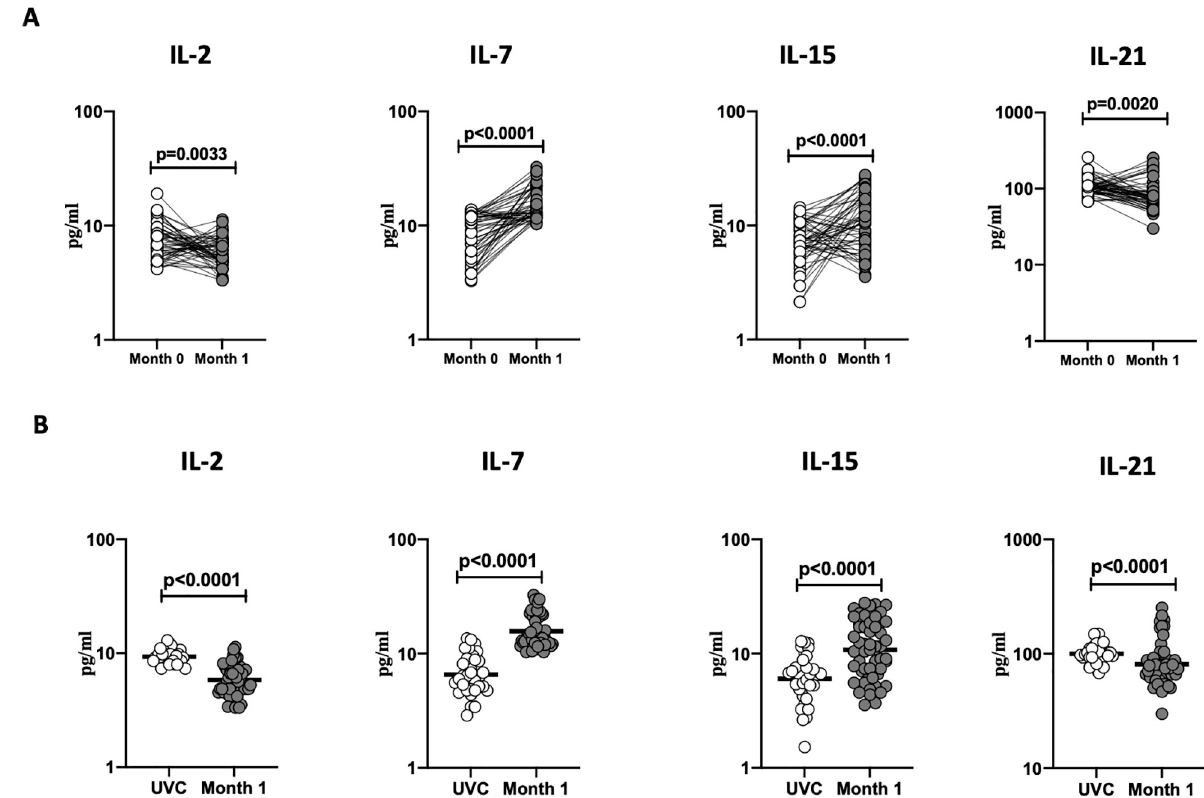
Fig 3. BCG vaccination is associated with altered circulating levels of γ c cytokines. (A) The plasma levels of common γ c cytokines IL-2, IL-7, IL-15 and IL-21were measured in BCG pre-vaccinated [M0] (n = 54) and month 1 following vaccination [M1] (n = 54). Data are shown as line diagrams with each line representing a single individual. p values were calculated using the Wilcoxon matched pair tests with Holms correction for multiple comparisons. (B) The plasma levels of common γ c cytokines IL-2, IL-7, IL-15 and IL-21in BCG unvaccinated (UVC) (n = 32) and post vaccinated [M1] (n = 54) individuals. The data are represented as scatter plots with each circle representing a single individual. p values were calculated using the Mann- Whitney test with Holm’s correction for multiple comparisons.